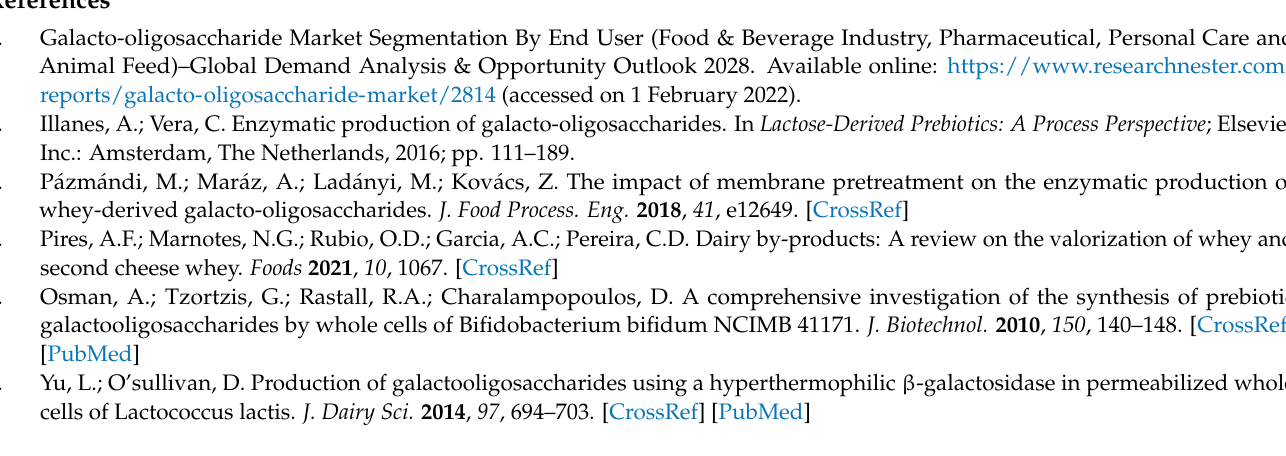
Abbreviations DP → degree of polymerization. EMR → enzymatic membrane reactor. GOS → galacto-oligosachrides. STR → stirred tank reactor. UF → ultrafiltration. GRAS →